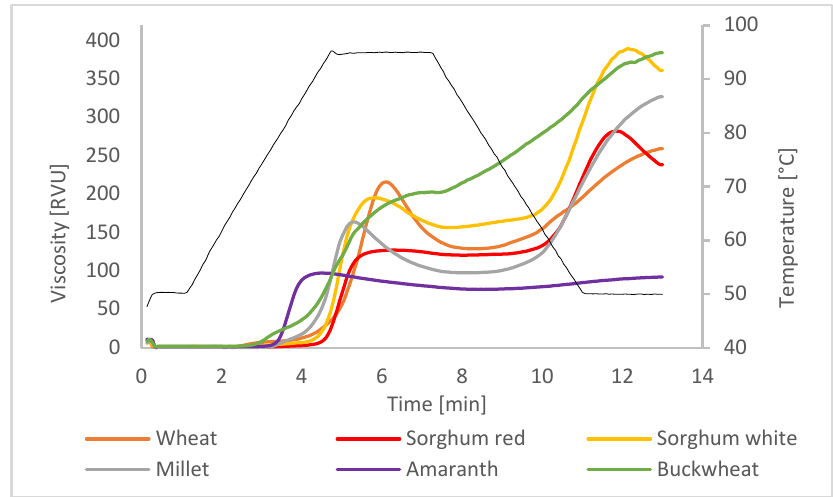
Figure 1. RVA pasting profile of selected gluten-free flours, compared with wheat flour (primary axis). Black line: RVA temperature profile (secondary axis).